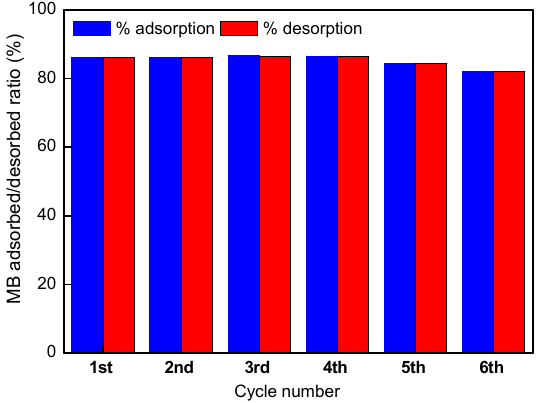
Figure 10. Desorption efficiency of MB onto A/ γ -Fe 2 O 3 /f-CNT composites after 6 adsorption- desorption cycles.